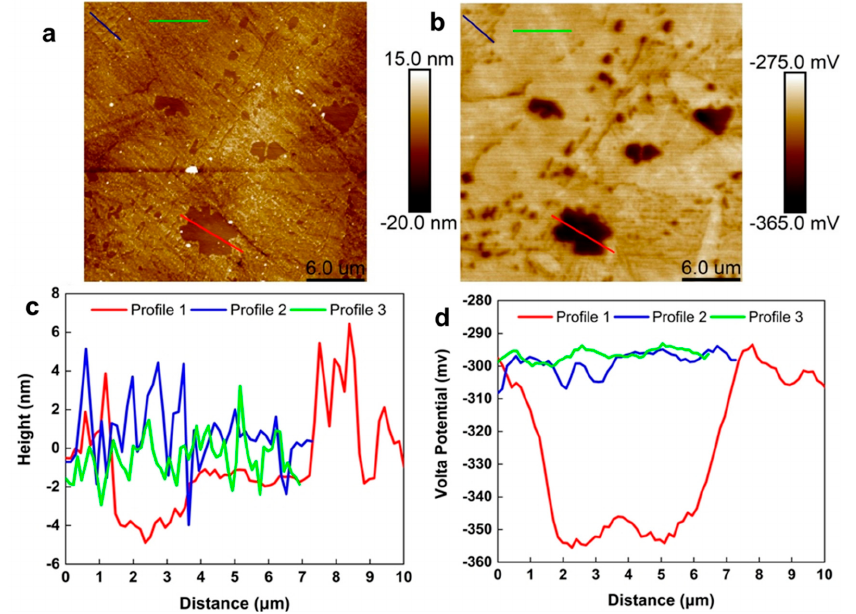
Figure 5. AFM topography image of the NAB ( a ), Volta potential map of NAB ( b ), the height profiles ( c ) and the Volta potential profile ( d ) of the κ II phase, κ III phase and α phase.